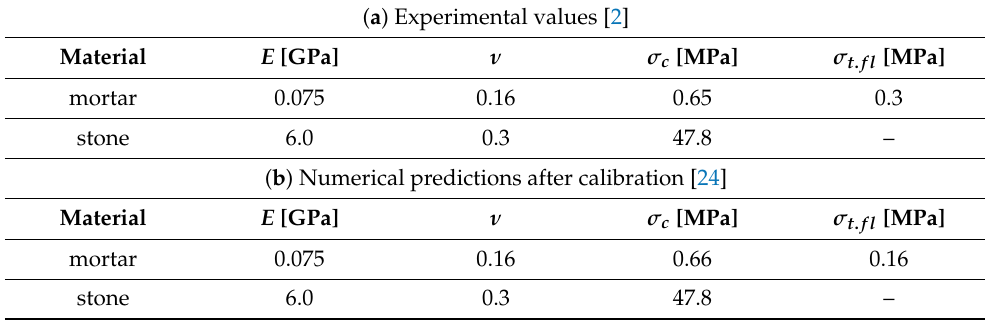
Table 4. Experimental and numerical macroscopic values of the elastic and strength